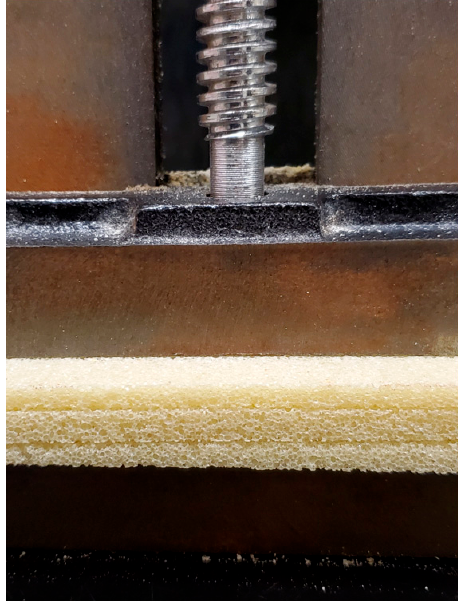
Figure 1. Polyurethane foam laminas. This image illustrates the setting of three superimposed laminas clamped with a vice. The thickness of each lamina is 3.3 mm, and the total thickness of the three laminas all together was ±10 mm. Table 1. Drill manufacturer, drill type, reference, wall angle, and tip angle.